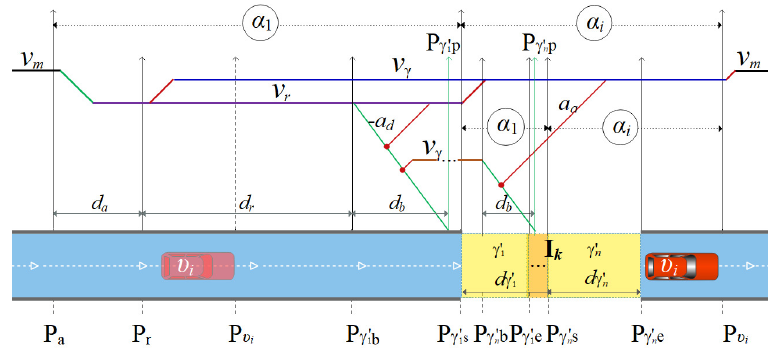
Figure 4. Vehicular Kinematic Features during Passing through S-CSs in the Temporal-Spatial